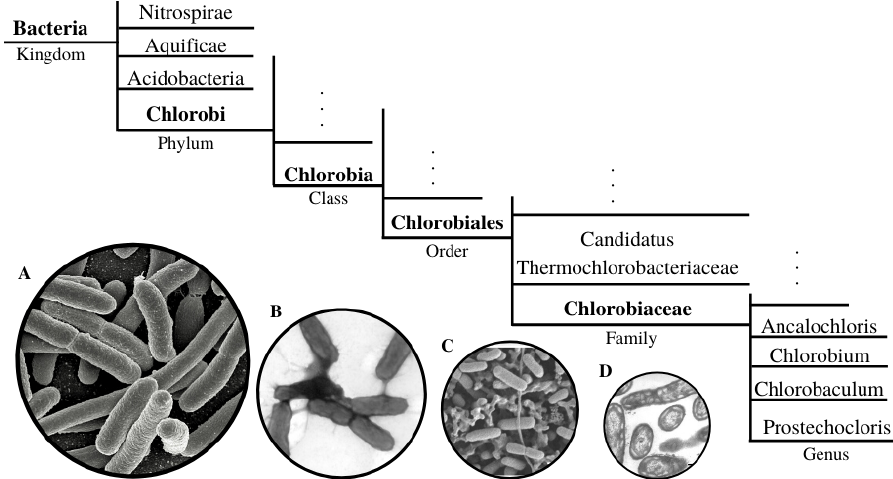
Figure 3. Taxonomy of Green Sulfur Bacteria (GSB). ( A ) Scanning electron micrograph of Escherichia coli . ( B ) GSB1 negatively stained cells viewed by transmission electron microscopy. ( C ) GSB1 cells deposited on a filter and viewed by scanning electron microscopy. ( D ) Thin section through GSB1 cells viewed by transmission electron microscopy with electron-transparent structures characteristic of chlorosomes. Adapted with permission from [16]. National Academy of Sciences, USA, 2005.